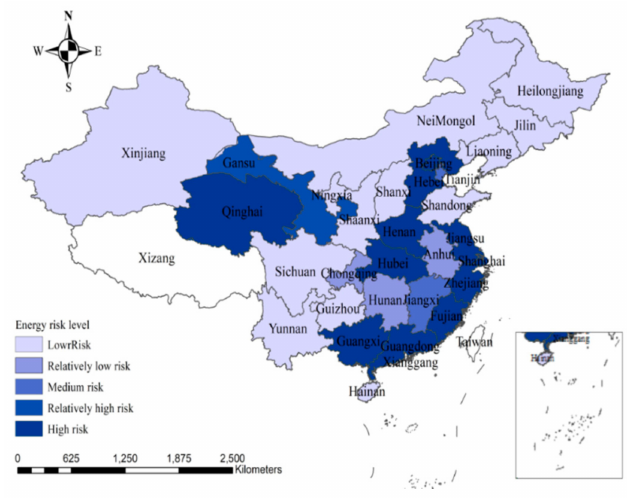
Figure 4. The risk level distribution of energy security in China 2020 (predicted).